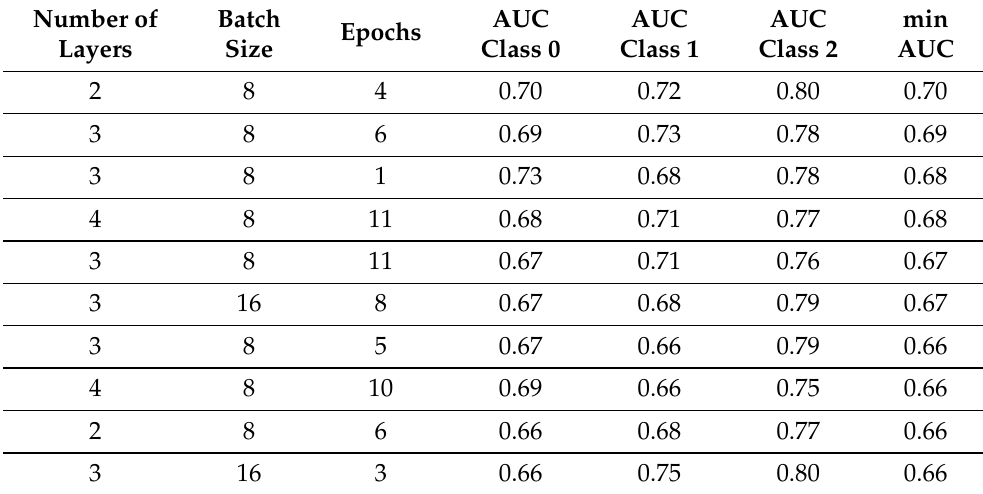
Table 16. Parameter configuration, AUC for each class, and minimum AUC for the validation set.